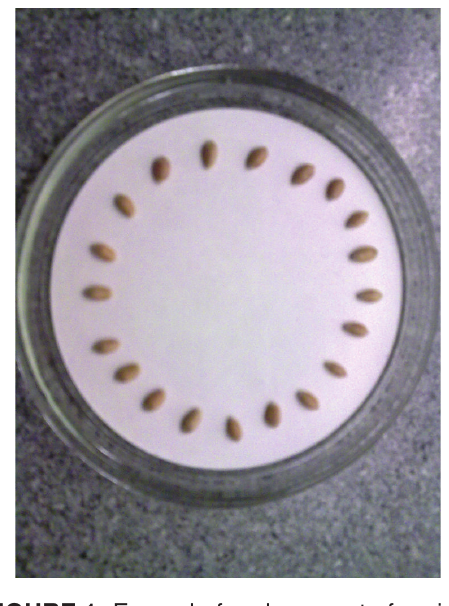
FIGURE 1: Example for placement of grains.